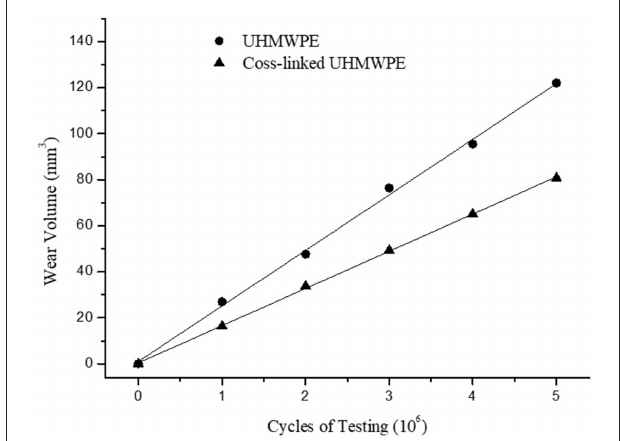
FIGURE 3 | Cumulative volumetric wear of UHMWPE and x-linked UHMWPE acetabular cups with cycles of testing. Results shown here are for a 28mm head.